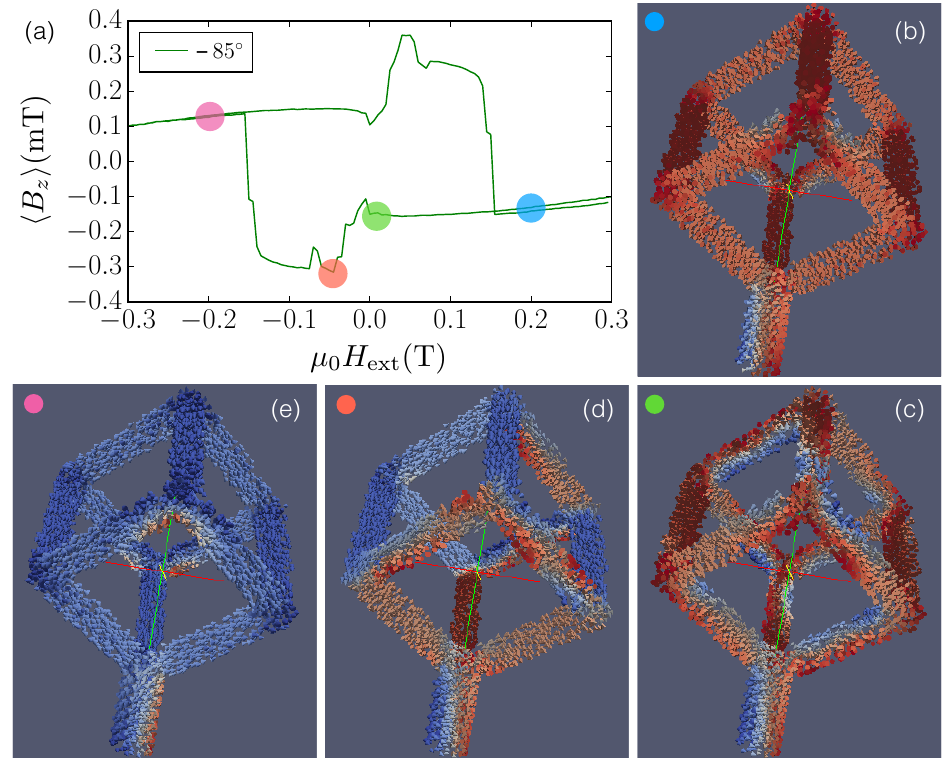
Figure 6. ( a ) Simulated hysteresis loop for θ = the y -component of the magnetization (red color: +1, blue: loop indicated by colored